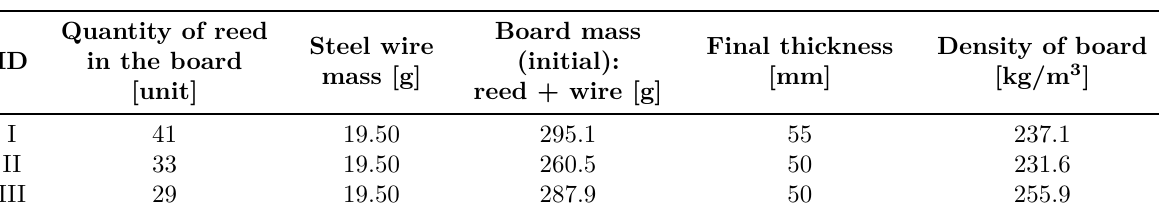
Table 1. Characteristics of the reed board prototypes.